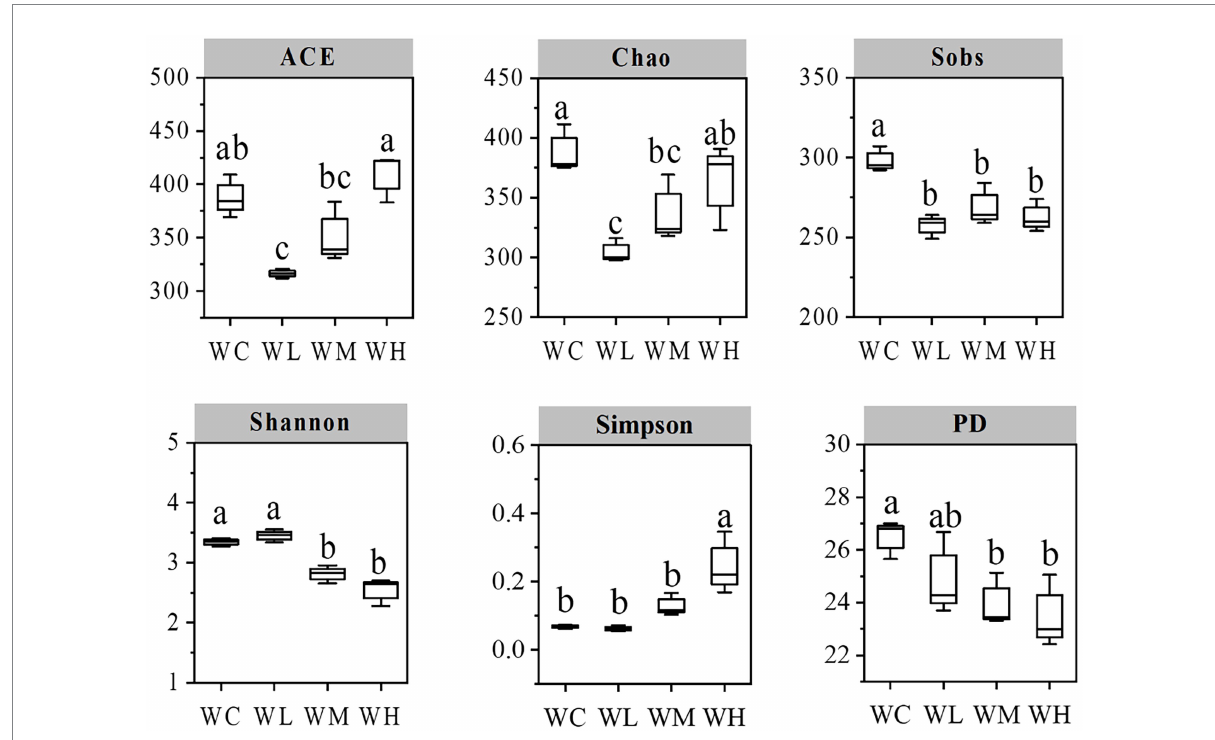
FIGURE 3 Index chart of microbial alpha diversity in aquaculture water. WC, WL, WM, and WH indicate four culture water treatments with different concentrations of AVH-AgNPs: 0, 6.23, 9.35, and 18.70 μ g/l, respectively. Values with different superscripts within the same picture are significantly different (Duncan test, p <